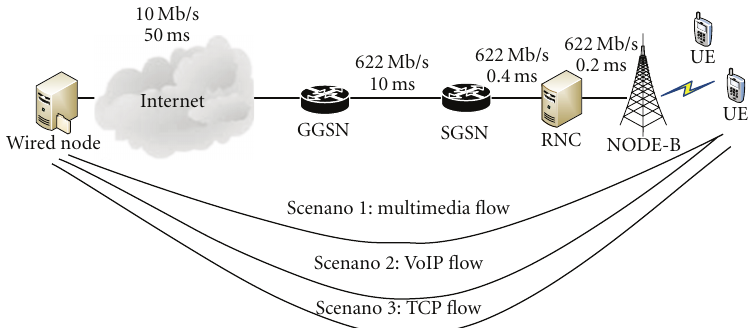
Figure 4: Simulation scenario used for ns-2 experiments.